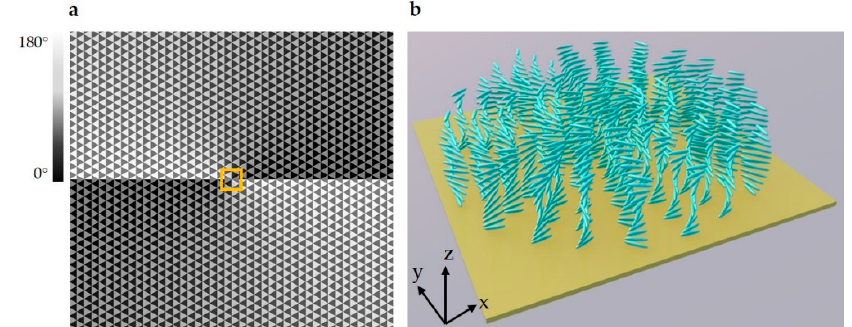
Figure 2. ( a ) The optical axis distributions of a hexagonal lattice Damman q-plate (DQP) with m = 1. ( b ) A schematic of LC directors in the yellow square region labeled in ( a ).